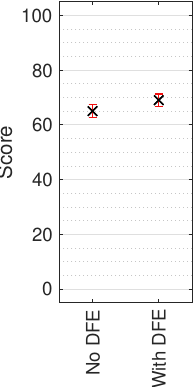
Figure 10. Median AB results with non-parametric 95% CI across all test sound locations. Score indicates perceived timbral consistency between the three tested orders of Ambisonics.